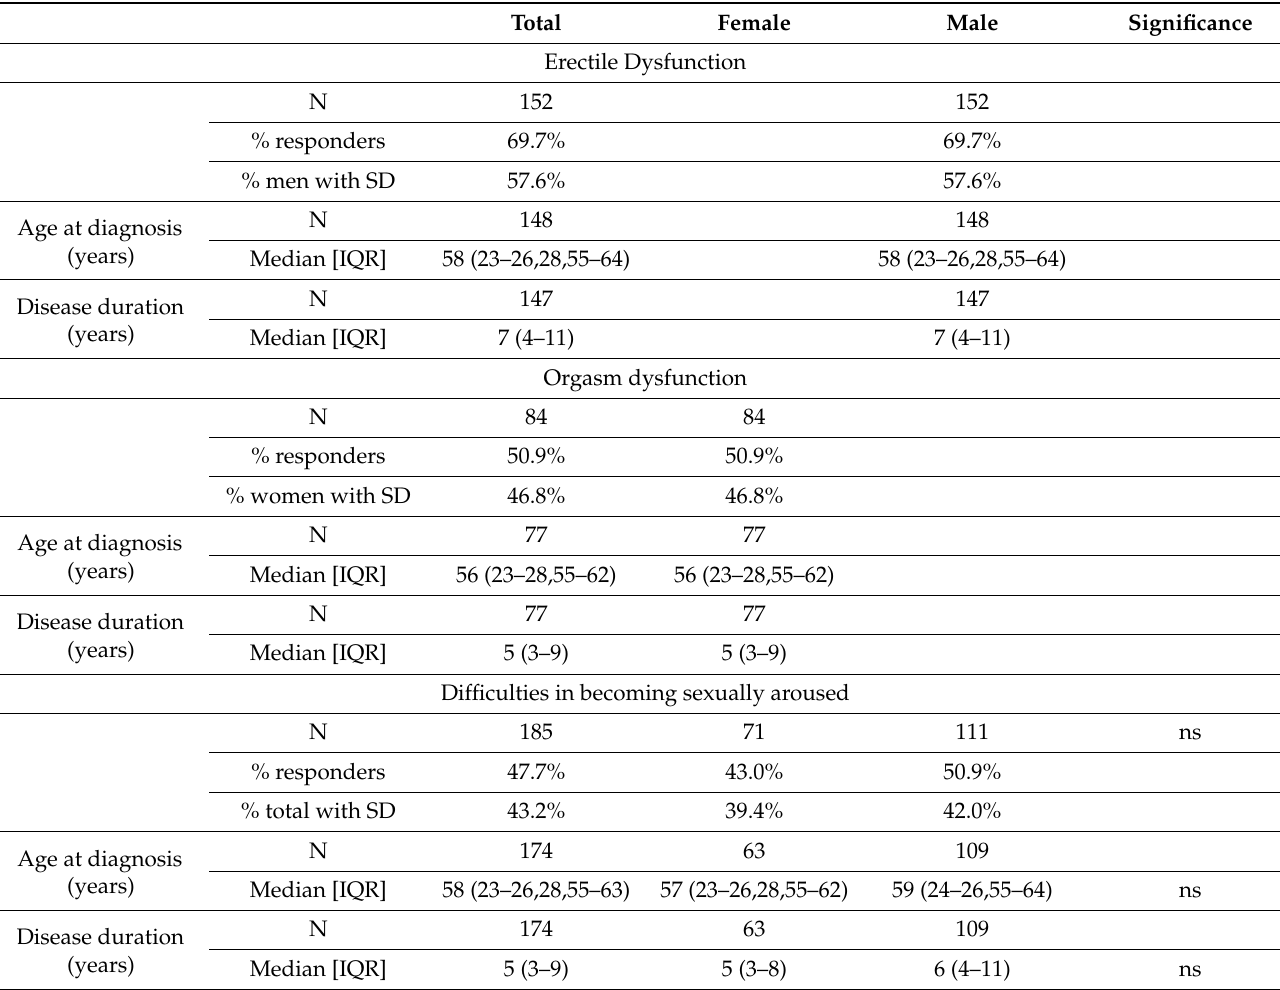
Table A2. Demographics of sexual dysfunctions in